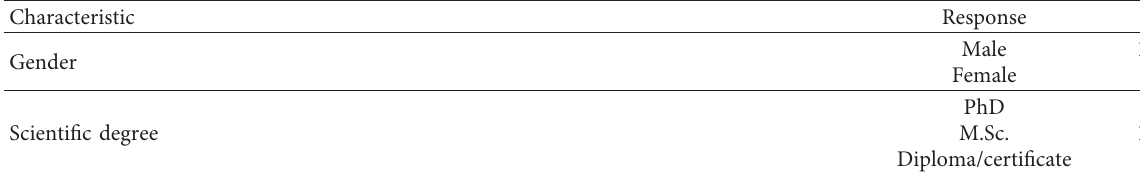
Table 1: Characteristics of the orthodontists participating in the